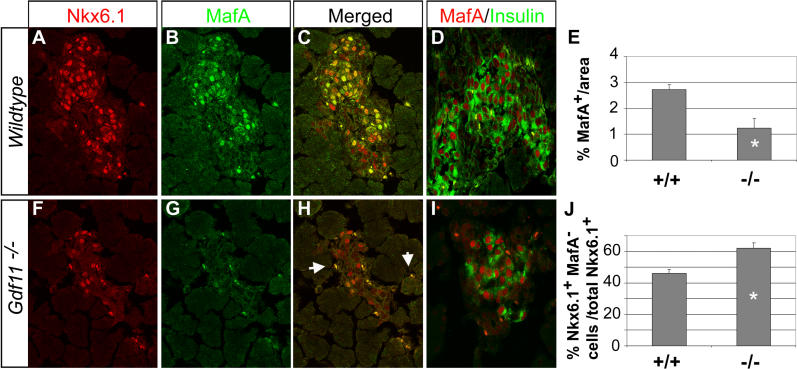
Reduced Expression of MafA by β Cells in Mice Lacking Gdf11(A and B) Immunohistochemical detection of Nkx6.1 (red) and MafA (green) in wild-type embryos at E17.5.(C) Merge of (A) and (B).(D) Coexpression of insulin (green) and MafA (red) in wild-type embryos at E17.5.(E) Quantification of MafA
+ cells per unit area in
Gdf11
+/+ and
Gdf11
−/− embryos.
(F and G) Immunohistochemical detection of Nkx6.1 (red) and MafA (green) in
Gdf11
−/− embryos.
(H) Merge of (F) and (G).(G–I) Reduction of MafA
+ cells in
Gdf11
−/− embryos.
(J) Increased number of Nkx6.1
+ MafA
− cells in
Gdf11
−/− mice at E17.5. Asterisks in (E) and (J) indicate
p < 0.05. Three to four animals per genotype were used for quantification. Arrows in (H) indicate autofluorescent blood cells. Original magnification of all images is 63×.